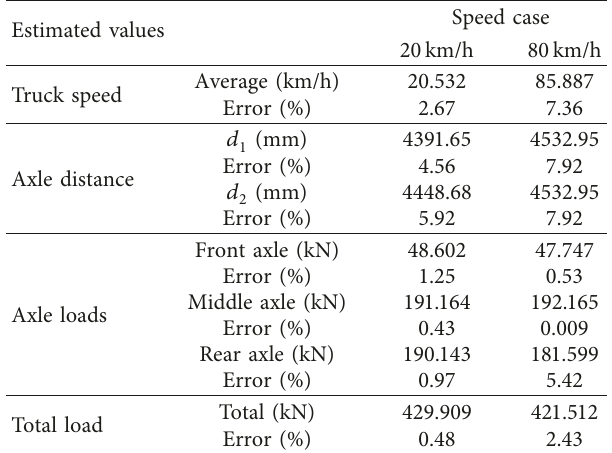
Figure 17: Flowchart for the identification of axle loads using the proposed BWIM bearing. Table 3: Estimated vehicle’s speed and axle loads using the pro- posed BWIM